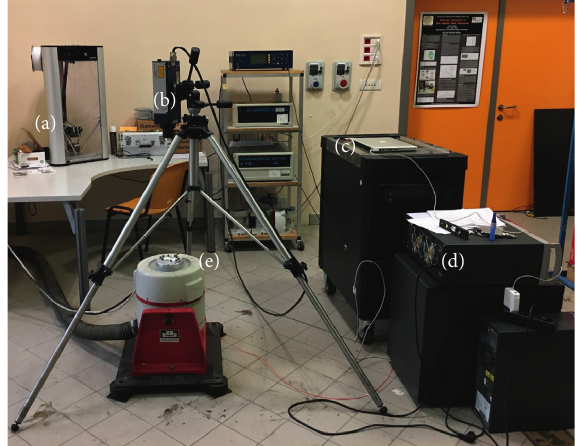
Figure 5: Picture of the experimental setup: (a) 3D printer, (b) laser vibrometer, (c) computer, (d) SCANDAS III, and (e) electrodynamic